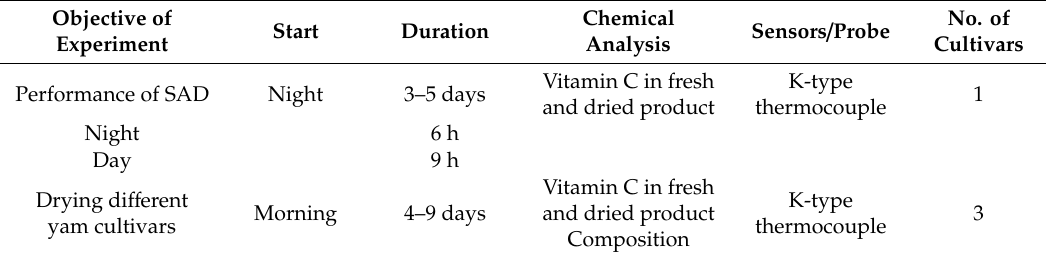
Table 1. Major characteristics of